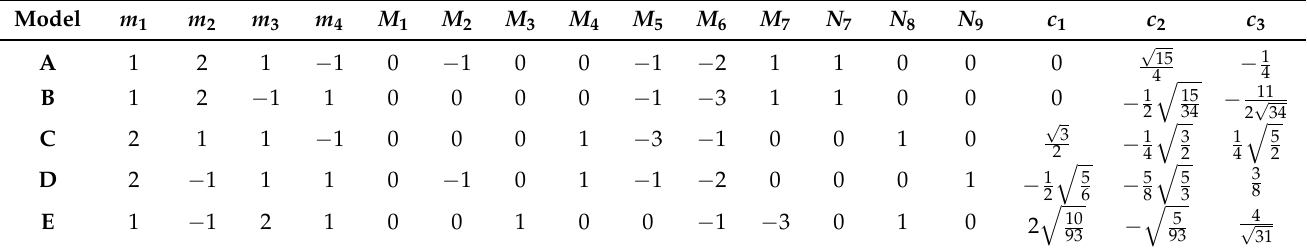
Table 2. Representative flux solutions along with the corresponding c i s for the five class of models: A, B, C, D and E.